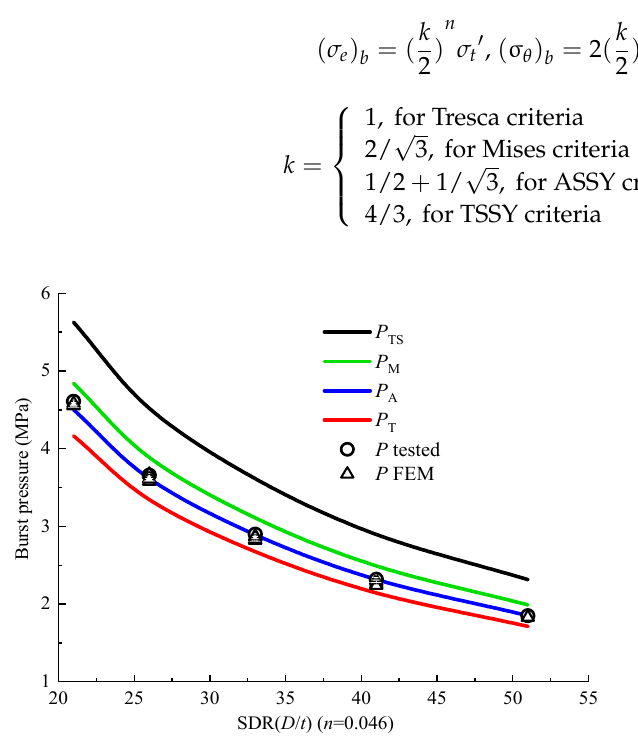
Figure 21. The relationship between burst pressure and SDR.